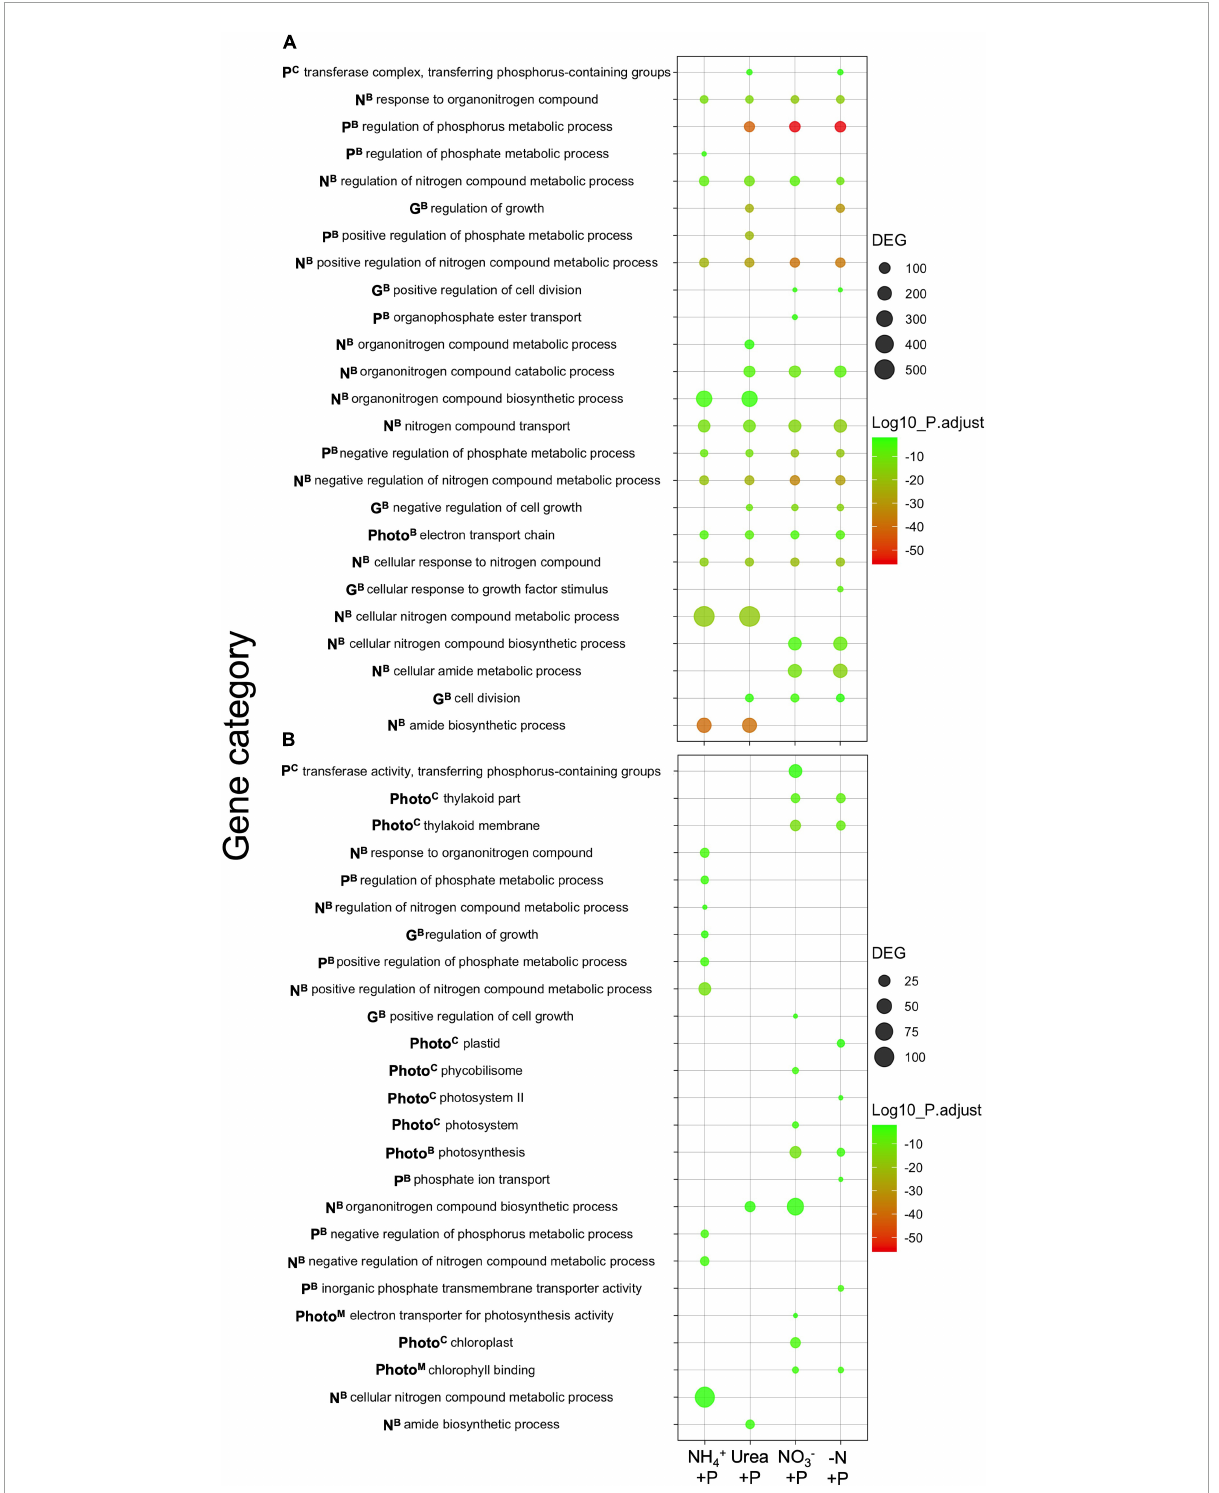
FIGURE7 Differentially expressed categories of genes [ (A) = 4-fold downregulated, (B) = 4-fold upregulated] relative to the control ( − N + P). Results are from transcript-based Gene Ontology (GO) enrichment analysis. The significant differential expression of genes was determined using Sleuth (Wald test; qval < 0.05), and gene categories were tested for significant differential expression using GOenrich (hypergeometric distribution analysis; padj < 0.05). Padj values were Log 10 -transformed for scaling purposes, and green - red colorations corresponded to lower - higher degrees of significance. Gene categories plotted were those associated with nitrogen (N) and phosphorus (P) assimilation, growth (G), as well as photosynthesis (Photo), while superscripts correspond to biological ( B ) , cellular ( C ) , and molecular ( M ) gene categories. The number of differentially expressed genes (DEGs) in gene categories are represented by circle